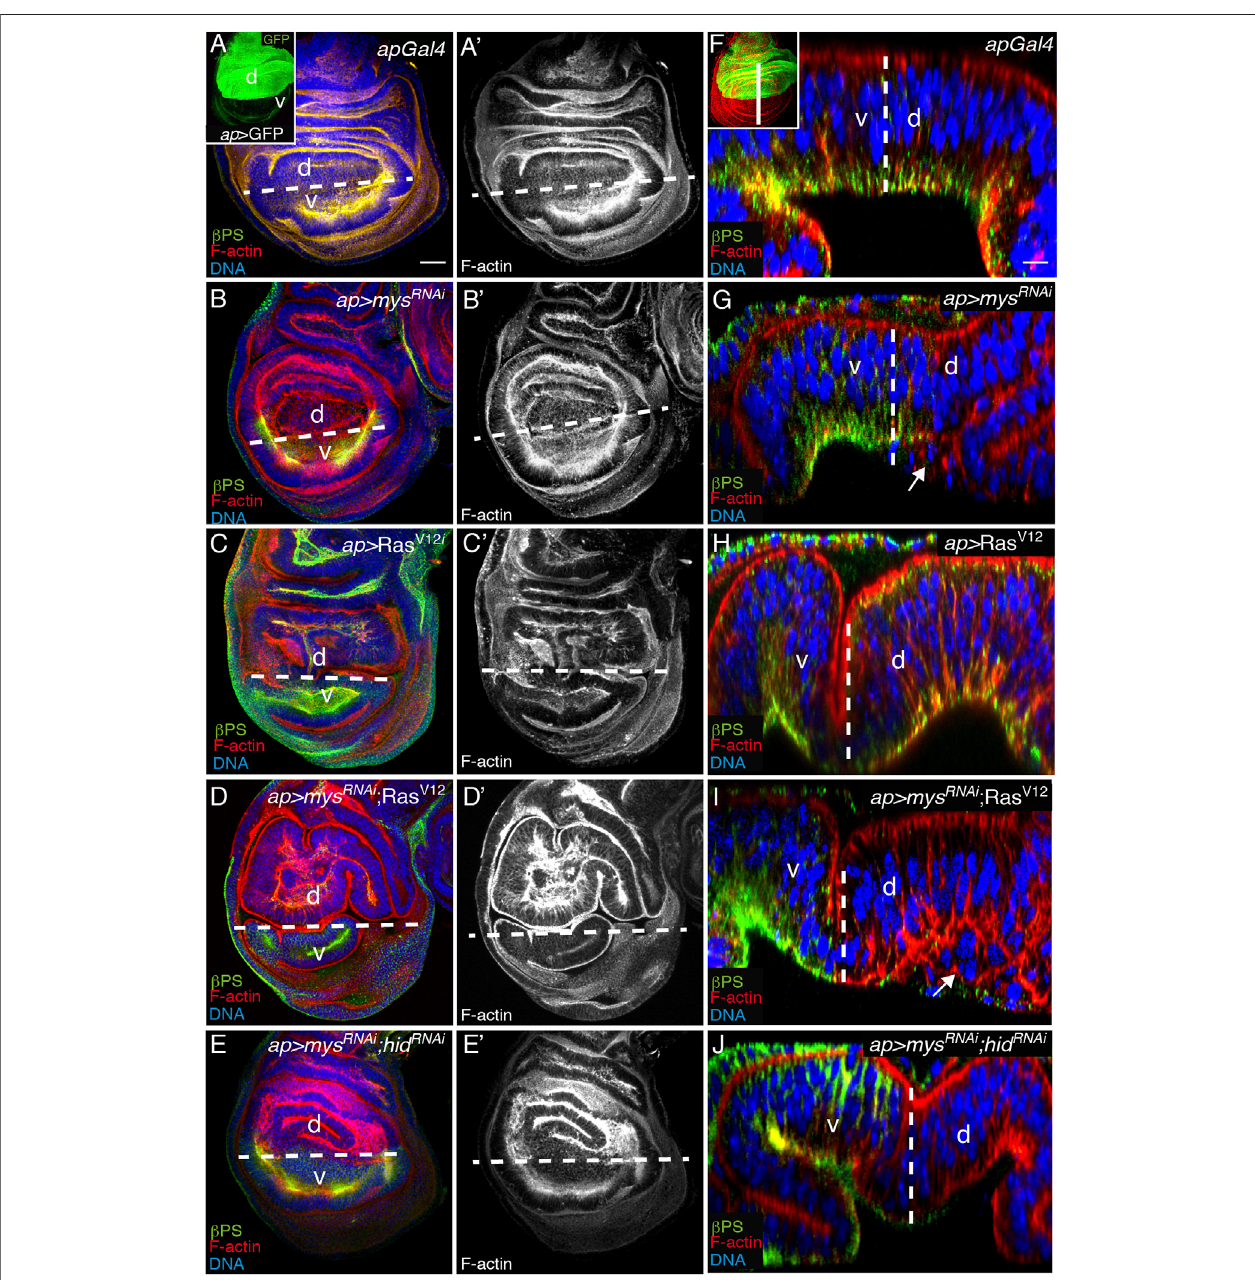
FIGURE 7 | Integrin knockdown stimulates basal extrusion of Ras V12 tumor cells. (A – J) Wing imaginal discs from third-instar larvae expressing the indicated UAS transgenes under the control of ap -Gal4 (inset in A), stained with anti- β PS [green in (A – E) and (F – J)] , the nuclear marker Hoechst [DNA, blue in (A – E,F – J) ] and Rhodamine Phalloidin to detect F-actin [red in (A – E) and (F – J) and white in (A 9 – E 9 )] . (A – E 9 ) Maximal projection of confocal views of wing imaginal discs. (A,A 9 ) Control apGal4 wing disc. (B,B 9 ) Wing disc expressing a mys RNAi under the control of apGal4 , ap > mys RNAi . (C,C 9 ) Wing disc expressing Ras V12 under the control of apGal4 , ap > Ras V12 . (D,D 9 ) Wing disc co-expressing mys RNAi and Ras V12 under the control of apGal4 , ap > mys RNAi ; Ras V12 . (E – E 9 ) Wing disc co-expressing RNAis against mys and hid under the control of apGal4 , ap > mys RNAi ; hid RNAi . (F – J) Confocal yz sections along the white straight line shown in inset in F of wing discs of the indicated genotypes. White dotted lines in all panels separate dorsal (d) from ventral (v) compartments. White arrows in G and I point to dead (G) and alive (I) cells extruded from the wing disc epithelium. Scale bar 30 μ m (A – E 9 ) and 10 μ m (F – J) .